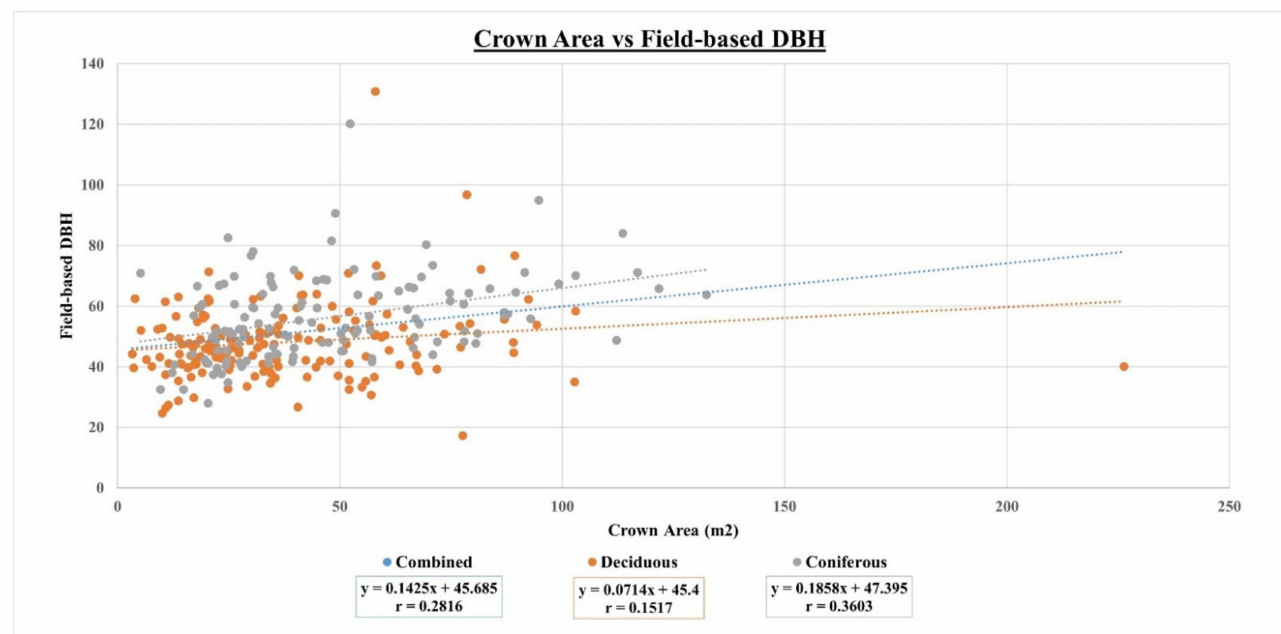
Figure 2. Linear regression between field measured dbh and crown area estimated using the UAS tree segments. A total of three trend lines and their respective equations are displayed for all species combined as well as for the deciduous species and coniferous species